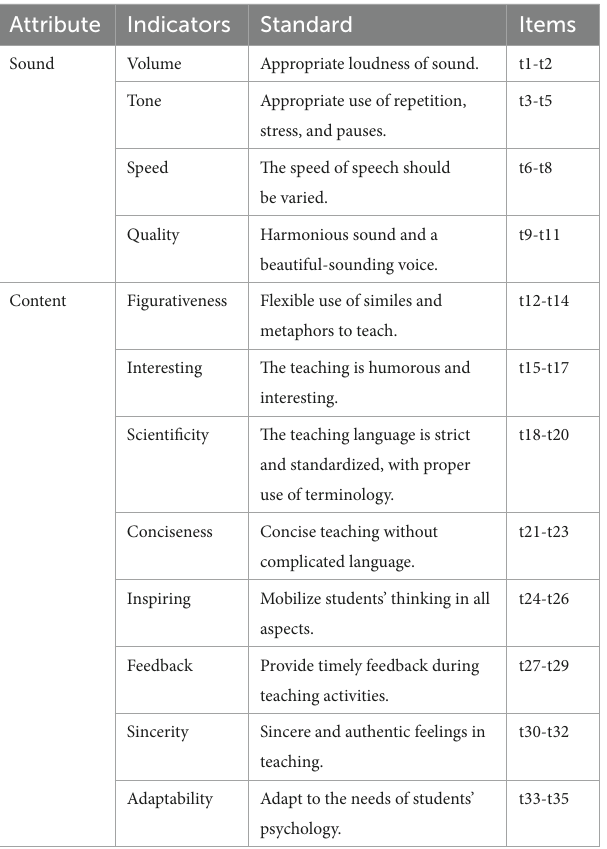
TABLE 1 Framework for analyzing audible teaching